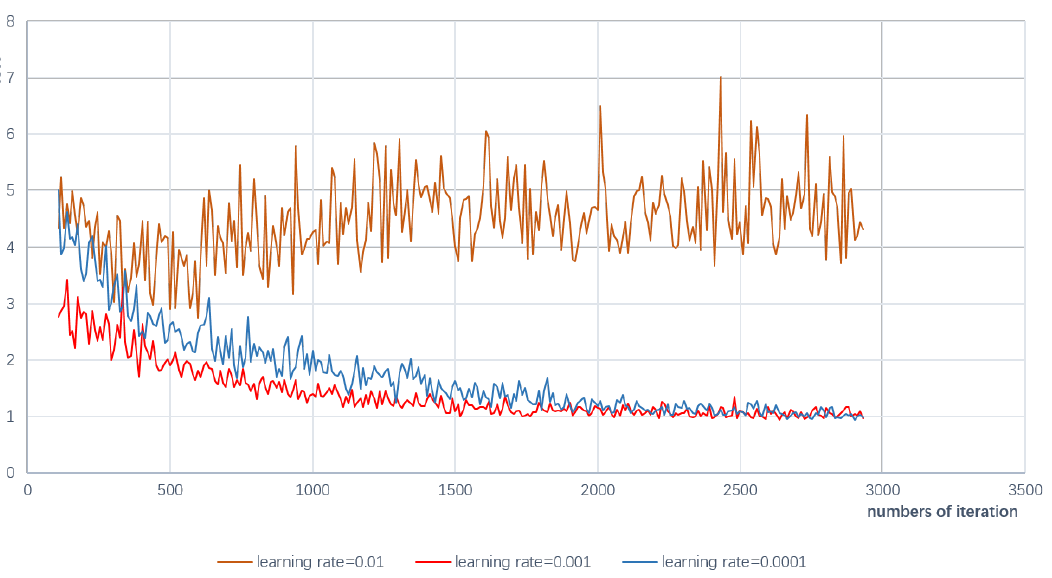
Table 1. Validation set of small-scale samples.